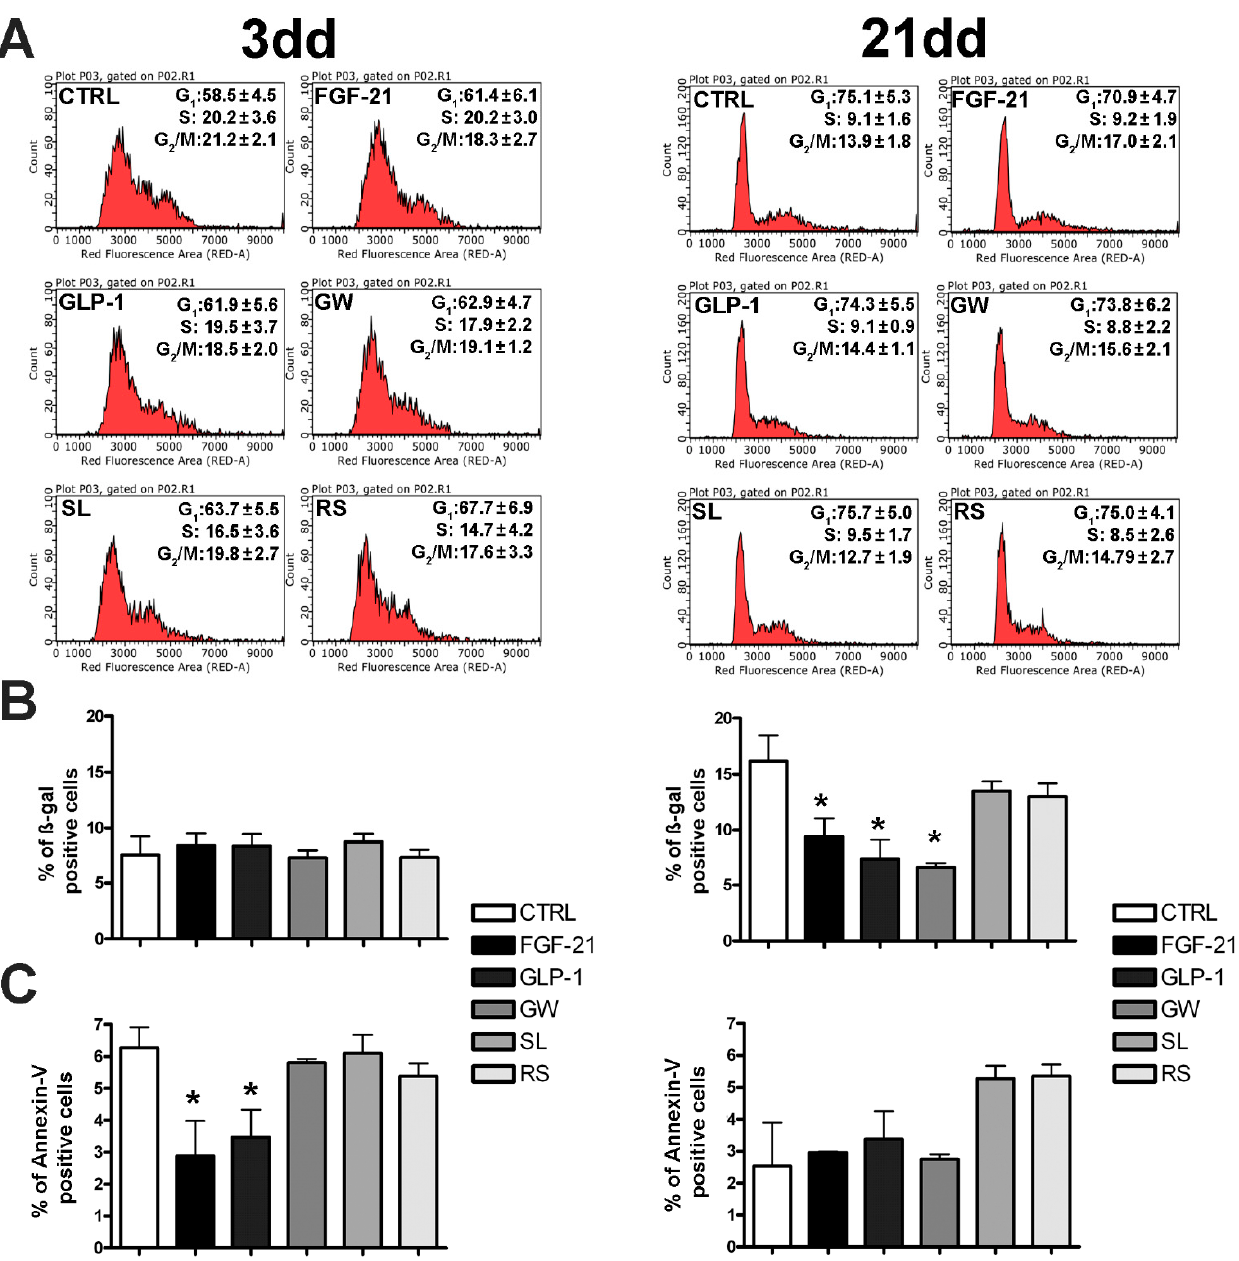
Figure 2. Cell growth, senescence, and apoptosis evaluation. ( A ) The picture shows the cell cycle profiles of mesenchymal stromal cells (MSCs) incubated with drugs and compared with controls (CTRL) following three and 21 days of treatment ( ± SD, n = 5 biological replicates). ( B ) Senescence analysis (following three and 21 days of treatment) by 4-methylumbelliferyl- β -d-galactopyranoside (MUG) quantitative fluorescent assay. A β -galactosidase substrate, 4-MUG only emits fluorescence when it is cleaved by the enzyme to generate fluorophore 4-methylumbelliferone. The fluorophore production was monitored at an emission/excitation wavelength of 365/460 nm. The data are expressed as arbitrary units (± SD, n = 5 biological replicates; * p < 0.05). ( C ) Apoptosis detection following three (left) and 21 (right) days of treatment by the fluorescein-conjugated Annexin V assay. Apoptotic cells were identified with a fluorescence microscope. The graph shows mean expression values in MSCs and in CTRLs (± SD, n = 5 biological replicates; * p < 0.05). FGF-21: fibroblast growth factor-21; GLP-1: glucagon-like peptide-1; GW: GW501516; SL: sildenafil; RS: rosiglitazone. For browning agent details, refer to Table 1.